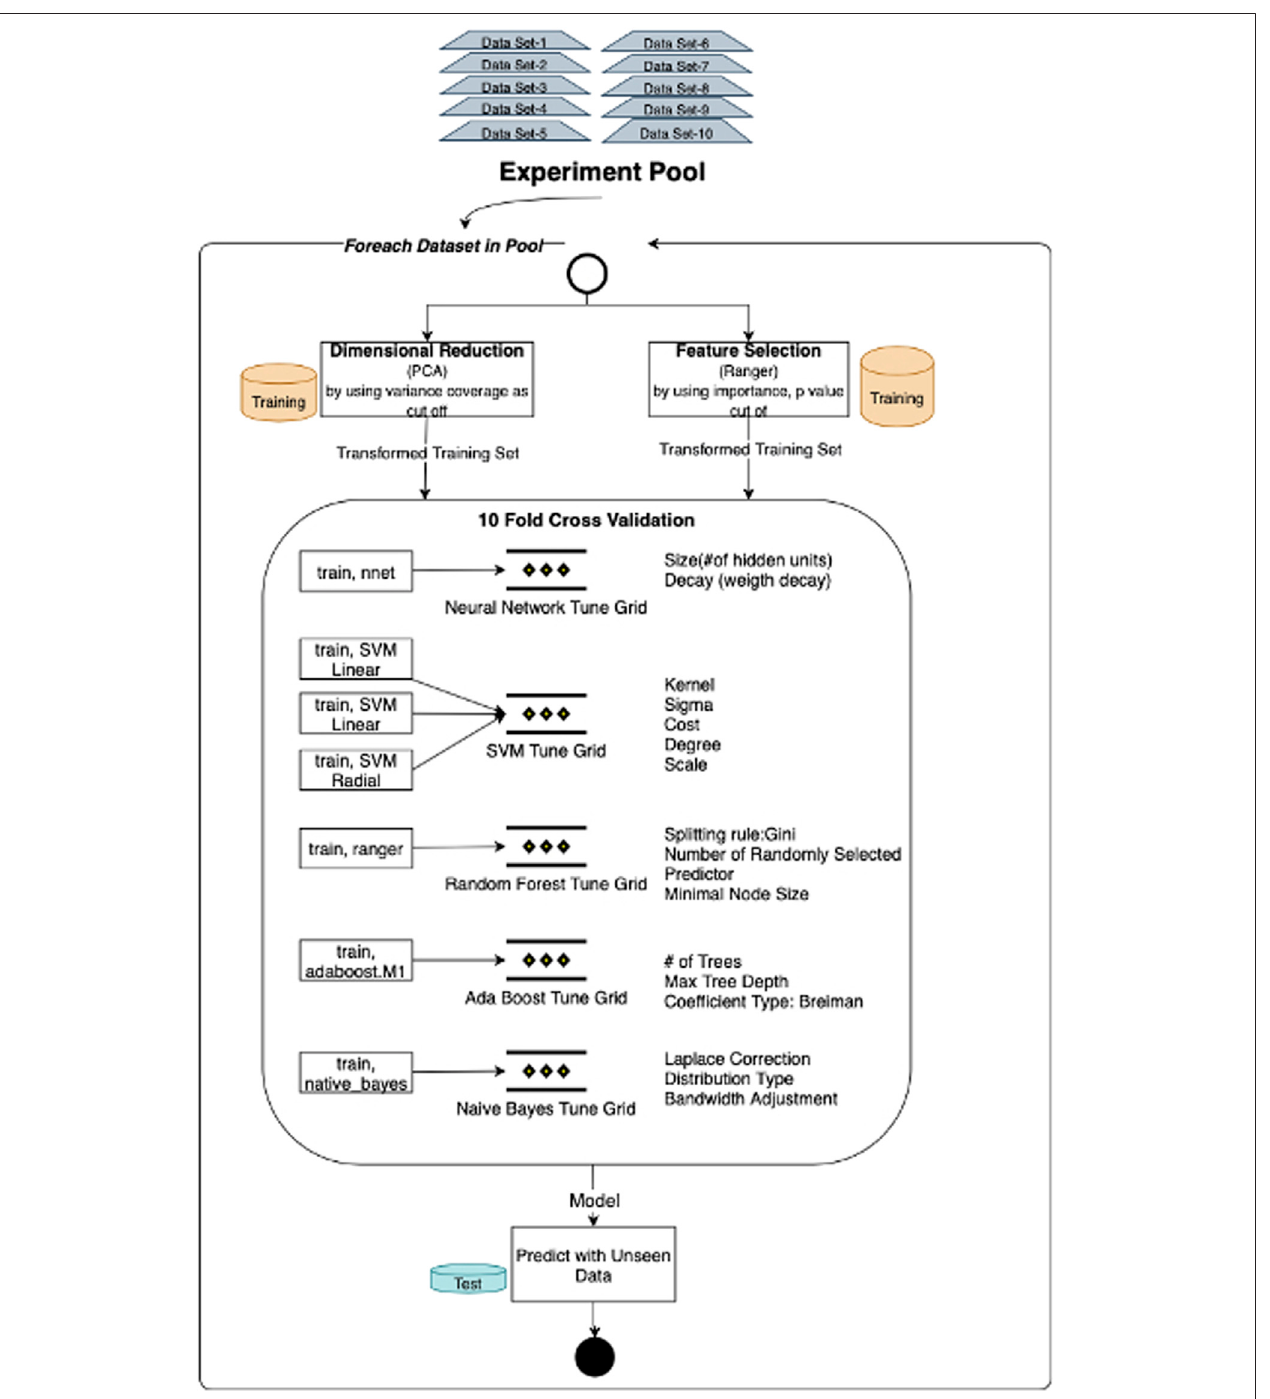
FIGURE 3 | Model training and testing process: experiment fl ow initiated by applying alternative dimensionality solutions, namely, PCA and feature selection. Through each experiment fl ow, models are trained with seven (SVMs with linear, radial, and polynomial kernels, neural networks, random forests, AdaBoost, and Naive Bayes) machine learning algorithms and tested with the same unseen data. Overall fl ow is repeated for each data subset in the experiment pool.